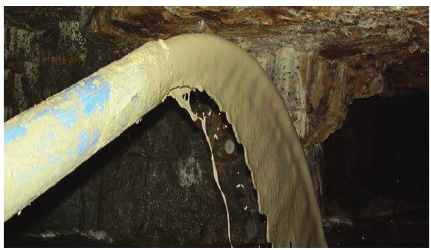
Figure 7: Combe down stone mines (source: http://www.